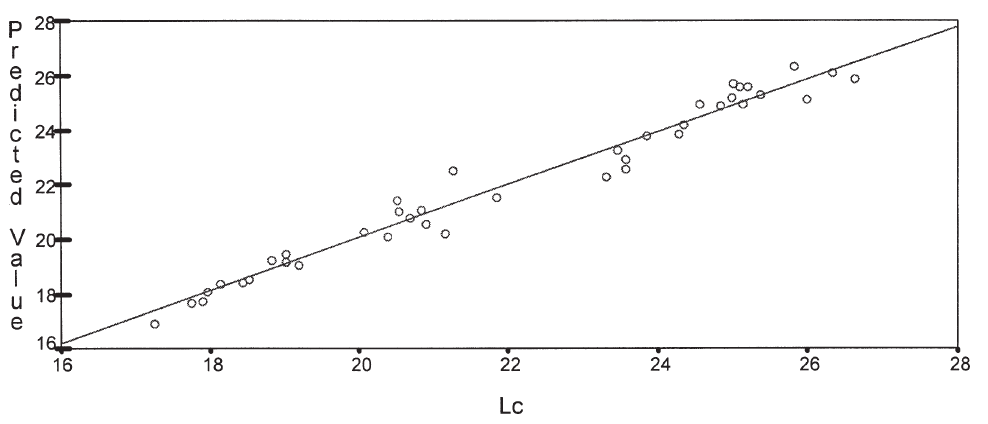
Fig. 1. Scattergraph on values obtained and predicted of L c in case with primary carcinomas of the stomach and the corresponding metastasis. The stepwise multiple logistic regression analysis showed that the use of only one variable, i.e., L is enough to differentiate primary tumours from their corresponding metastatic